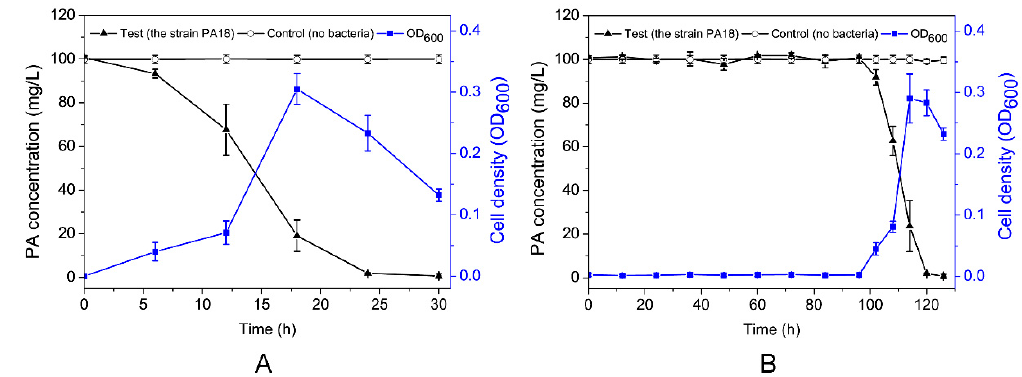
Figure 2. Utilization of PA during the growth of Rhodococcus sp. PA18 in mineral salts medium (MSM) (pH 7.0). The strain was pre-cultured with PA ( A ). The strain was pre-cultured in a Luria Bertani (LB) medium ( B ).